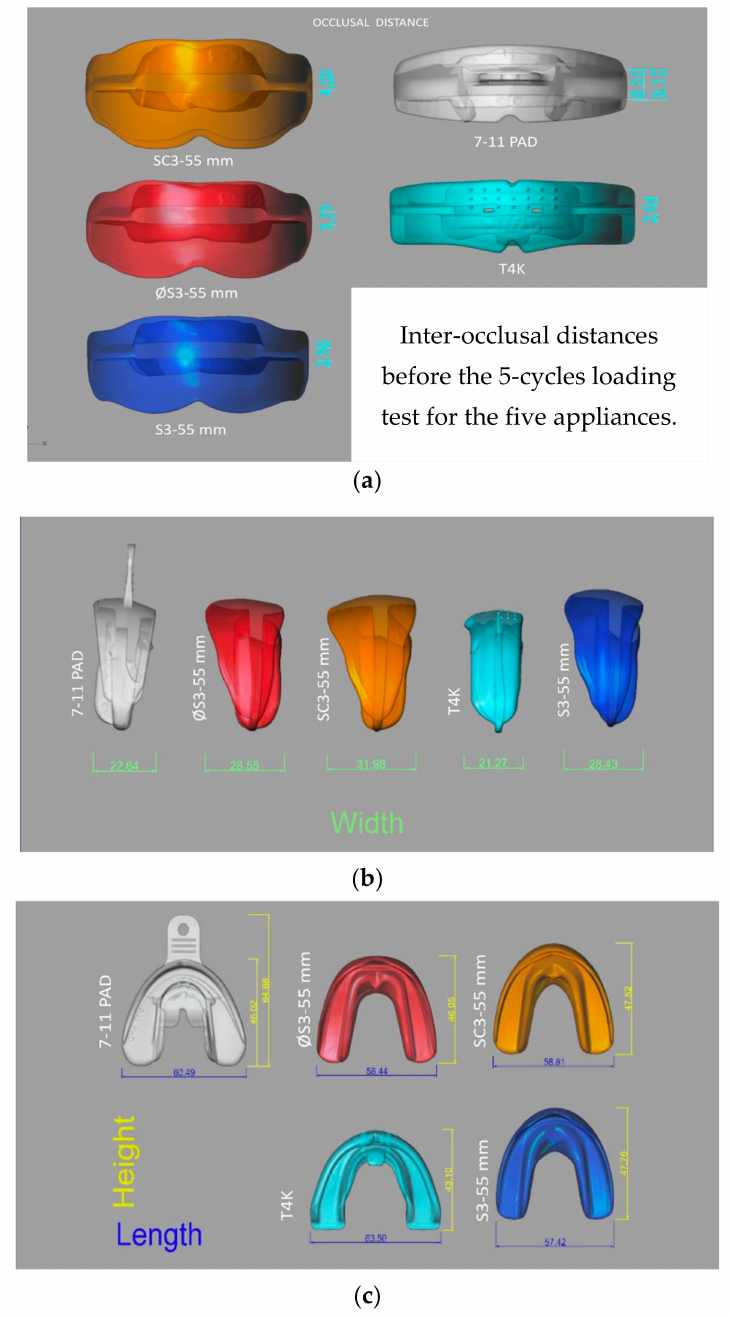
Figure 1. Measurements obtained for the five devices before the 5-cycles test, in millimeters: ( a ) occlusal distance; ( b ) width; ( c ) length and